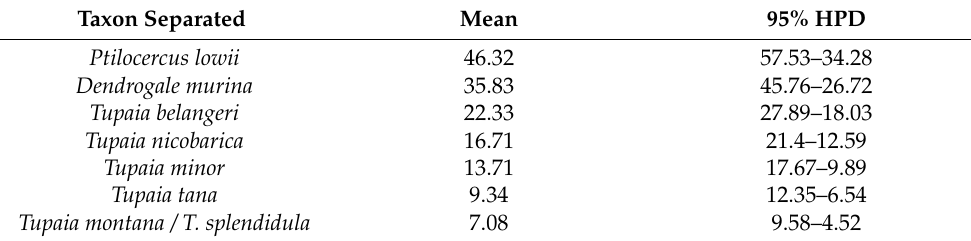
Table 2. Divergence time estimates for the major lineages within